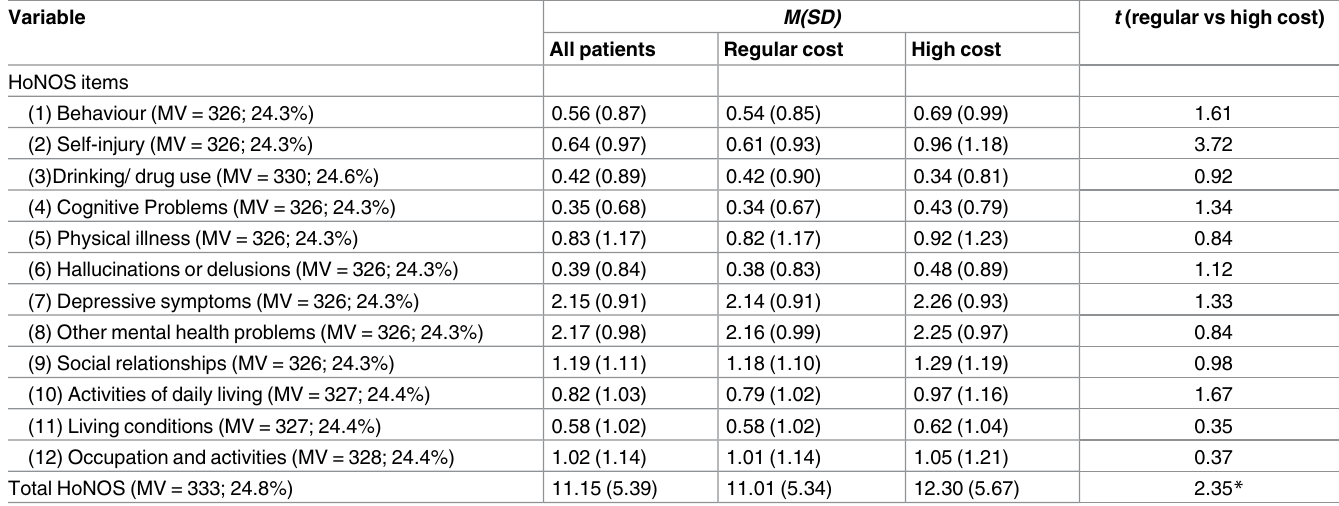
Table 2. Differencesin HoNOS scores between ‘regular cost’ and ‘high cost’ patients 1,2